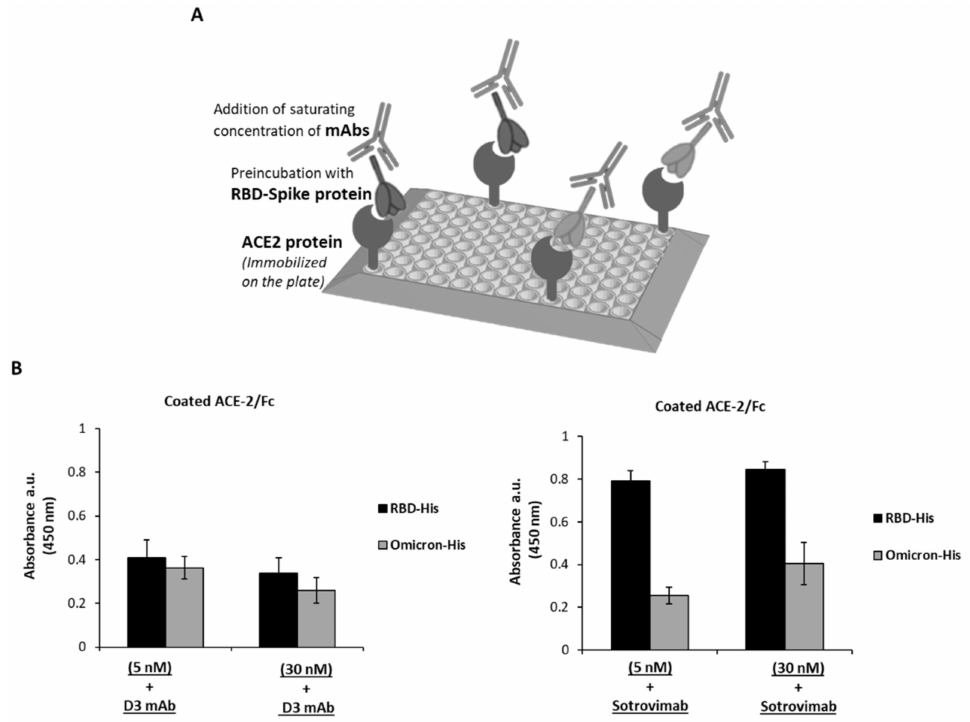
Figure 4. Comparison of the binding of D3 and Sotrovimab mAb to RBD-SARS-CoV-2 protein or its Omicron variant by ELISA assays. ( A ) Graphical representation of the ELISA assay to test the binding of D3 to the RBD proteins. ( B ) ACE-2/Fc recombinant protein was immobilized on the plate and pre-incubated with rRBD-SARS-CoV-2/His or rRBD-Omicron/His variant protein at concentrations of 5 nM or 30 nM. D3 or Sotrovimab mAb were added and detected by an anti-Fab HRP-conjugated antibody for their binding either to the parental RBD (black bars) or the Omicron variant (gray bars). The absorbance values were reported as the mean of at least three determinations. Error bars depicted means ±